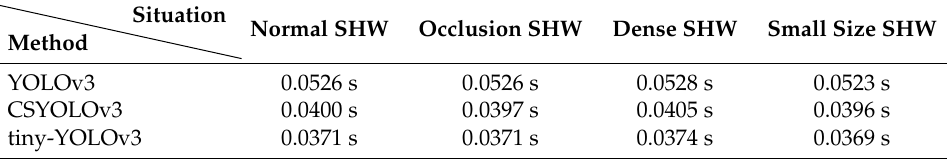
Table 2. Time of per image processing for four SHW